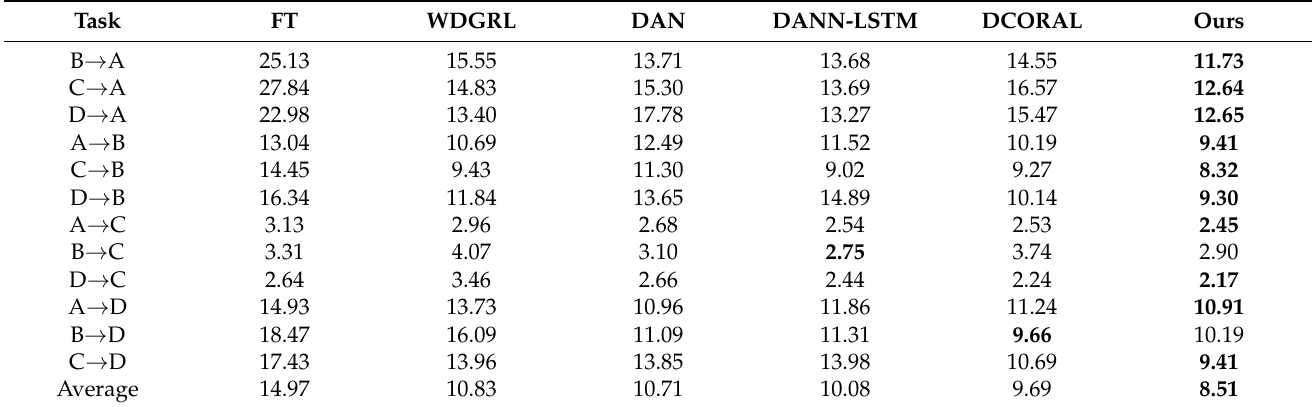
Table 3. RMSE Performance. The best performance of each task is highlighted in bold.